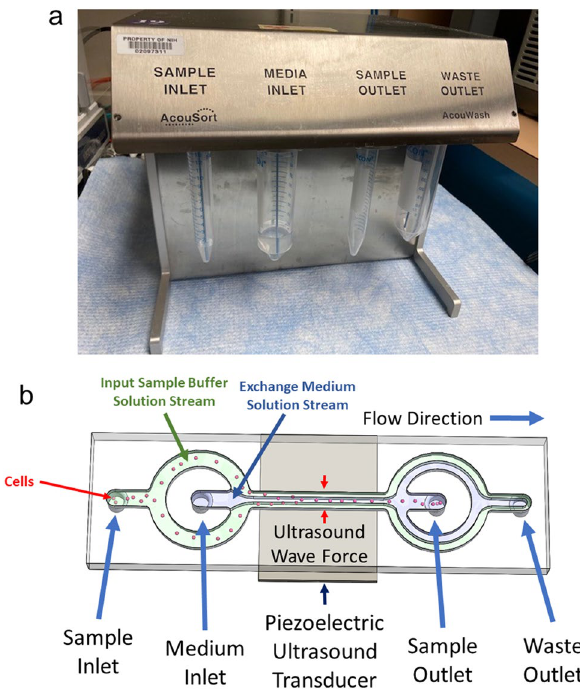
Figure 2. Details of the acoustophoresis cell washing process. ( a ) The AcouWash device used to wash cells using the acoustophoresis cell washing process. The methods section has a full description of its operation. ( b ) A pictorial showing the basic principle of the acoustophoresis cell washing